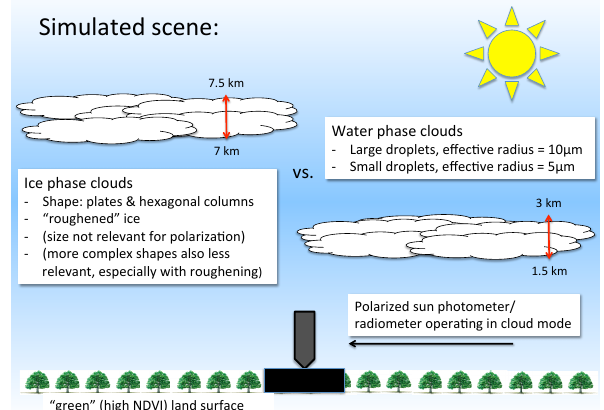
Figure 1. Illustration of the simulated scene. Sky radiances were generated for a variety of solar zenith angles (15, 30, 45 and 60 ◦ ), cloud optical depths (2.5, 5, 7.5, 10, 15, 20 and 30) and ice particle or cloud droplet types (see Section 2). Surface reflectance was pro- vided by observations of a high normalized difference vegetation in- dex (NDVI) from late summer in central Oklahoma (Knobelspiesse et al.,